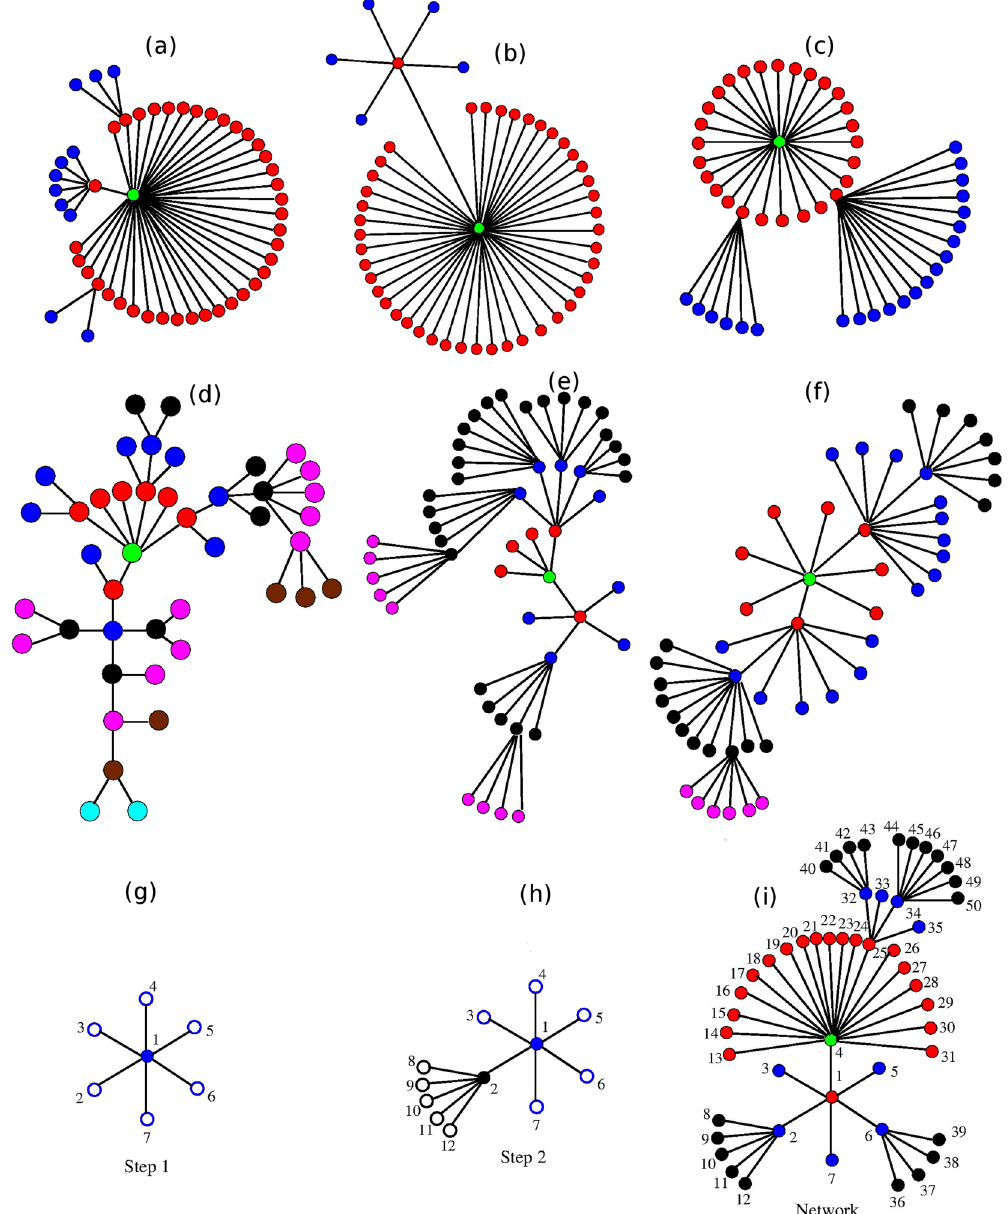
Figure 1. Realizations of generalized scale-free networks with the parameter set ( γ , K min ):(1, 2), (1, 4),(1, 6) ( a – c ) in the figure), and (4, 2), (4, 4), (4, 6) ( d – f ). Construction procedure in detail for the parameters ( γ , K min ) = (2.5, 4) ( g – i